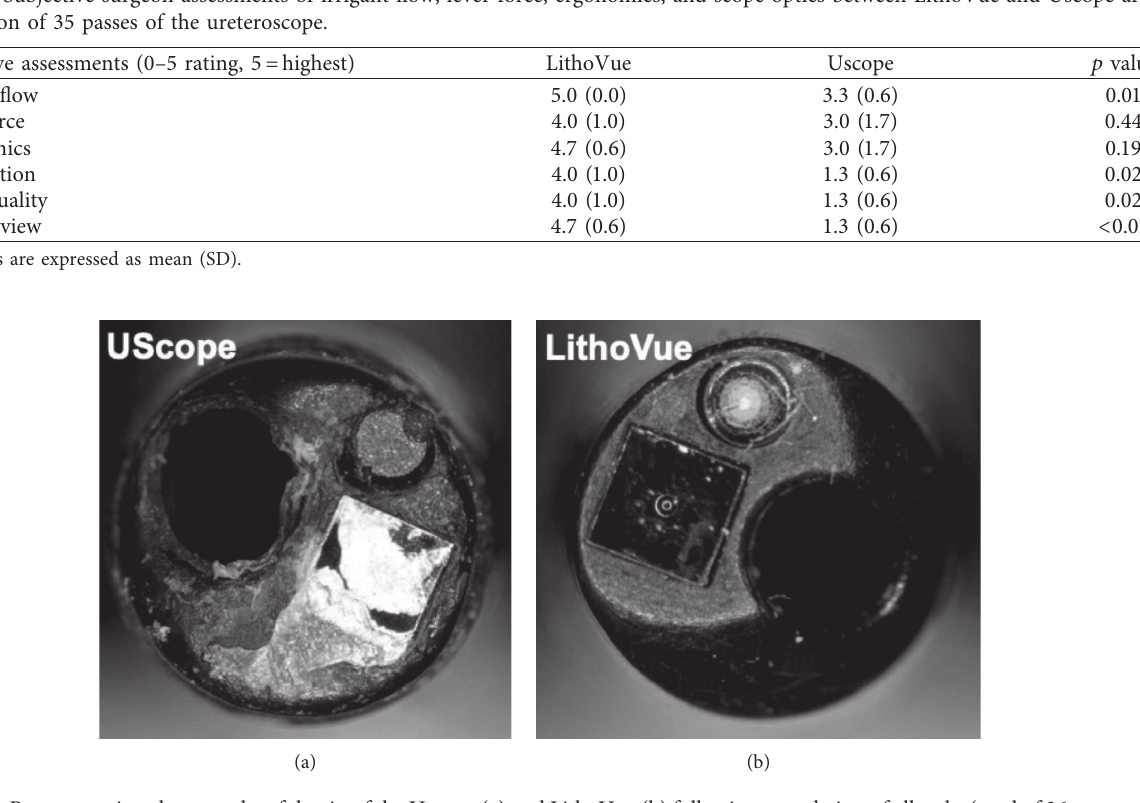
Figure 1: Representative photographs of the tip of the Uscope (a) and LithoVue (b) following completion of all tasks (total of 36 passes per